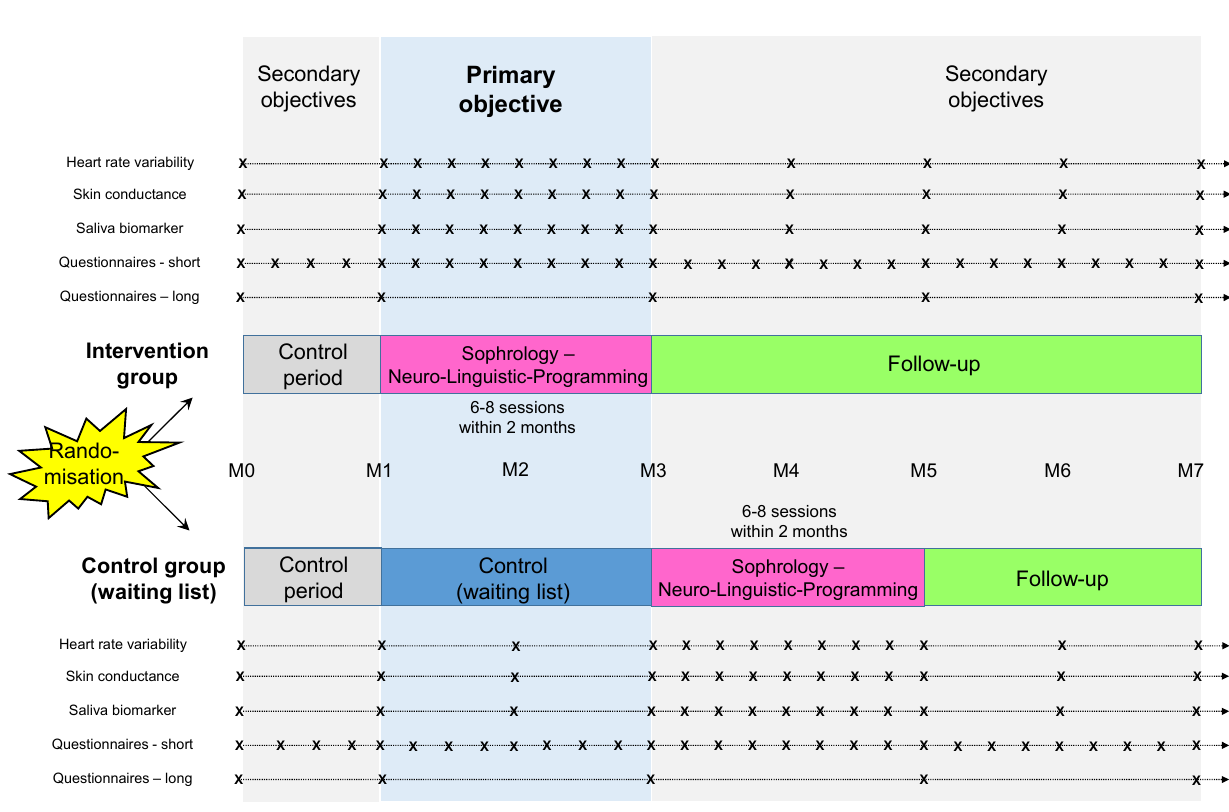
Figure 1. Study design. “×” for each time of measurement